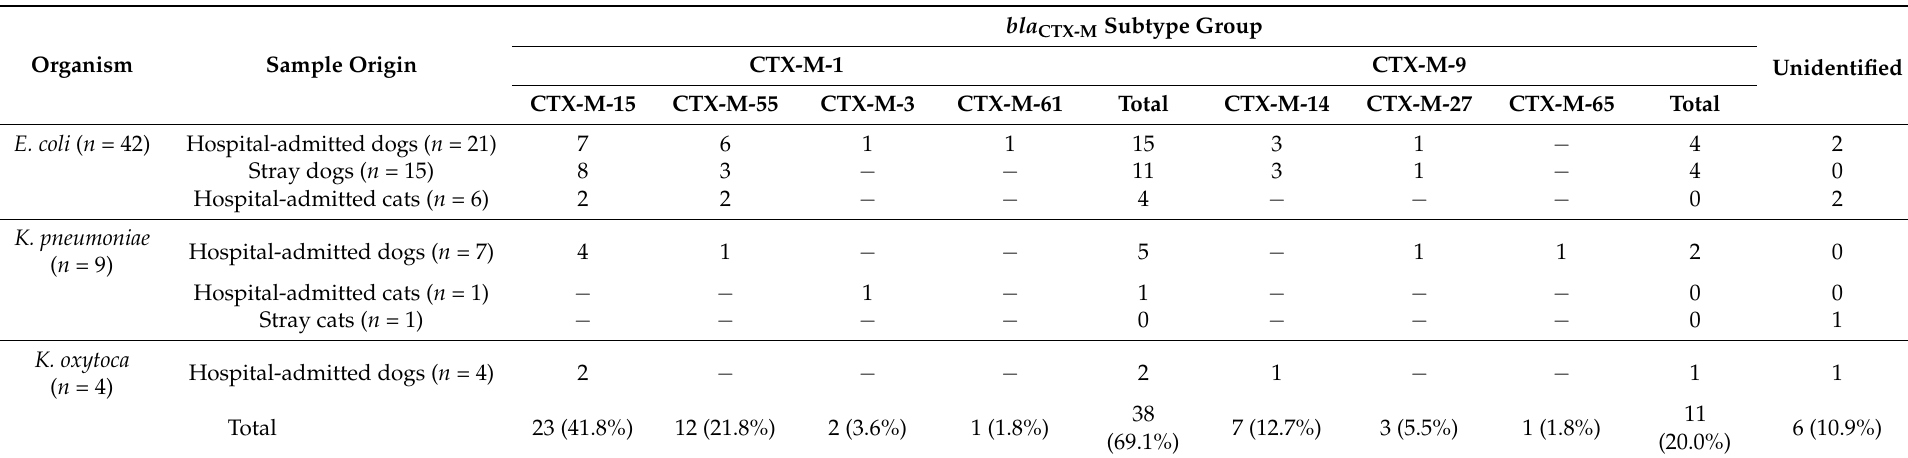
Table 2. CTX-M subtype detection of 55 bla CTX-M -positive Enterobacterales